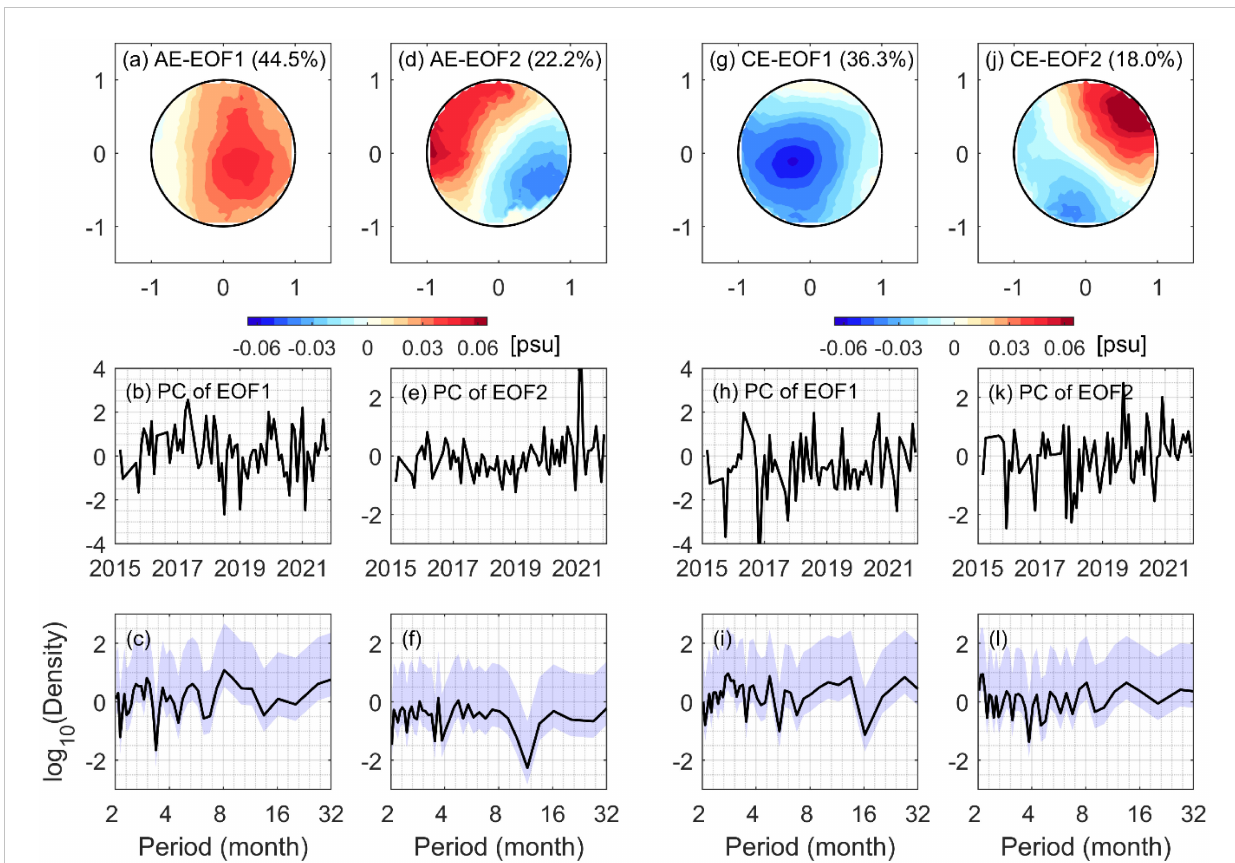
FIGURE 5 The (A) spatial pattern (unit: psu), (B) PC of EOF1, and (C) power spectrum of PC of the AE in the SCS. The shading indicates the salinity anomaly mode of the eddy composites and the purple area indicates the 95% con fi dence interval. Subgraphs (D – F) are for EOF2 of the AE in the SCS. Panels (G – L) are the same as (A – F) but for the fi rst two modes of EOF of the CE in the